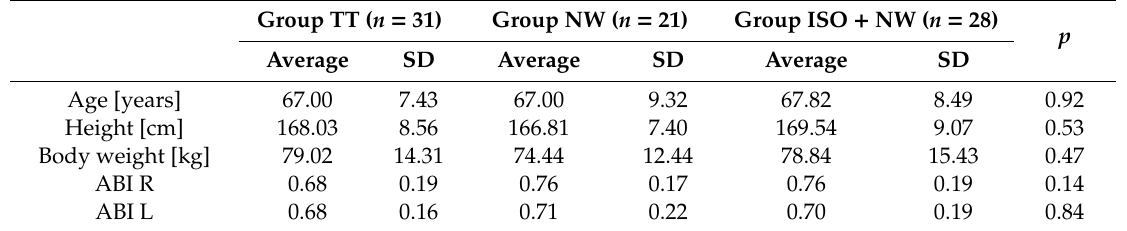
Table 1. Patient characteristics.